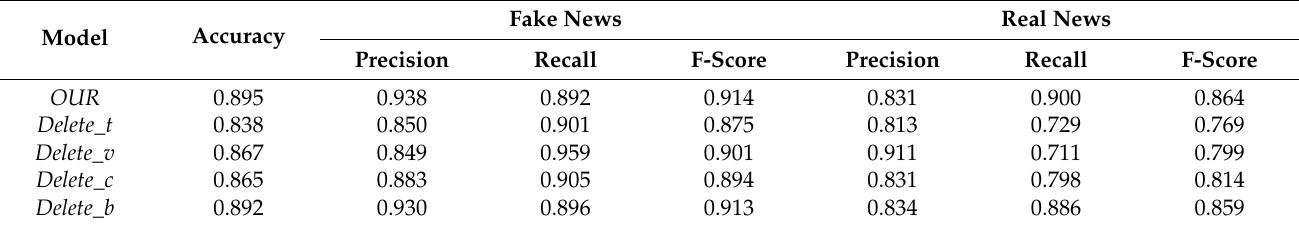
Table 7. Ablation experiments on Twitter dataset.